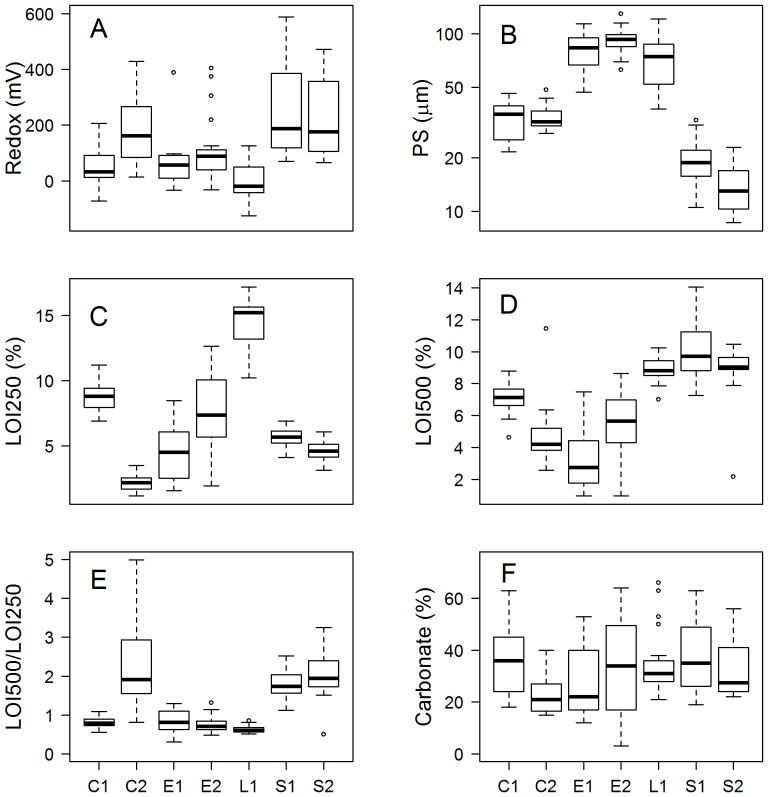
Sediment characterisation at different sites.A – particle size (log-scaled), B – loss on ignition (250°C), C – loss on ignition (500°C), D – ratio between LOI500 and LOI250 (one outlier, ratio = 5.8 is not shown for reasons of clarity), E – carbonate content (%) and F - redox. Site codes (X-axis): C - Creran, E - Etive, L - Leven, S - Spelve followed by site number (1 or 2). Sample sizes (per site) are shown in
Table 1
.